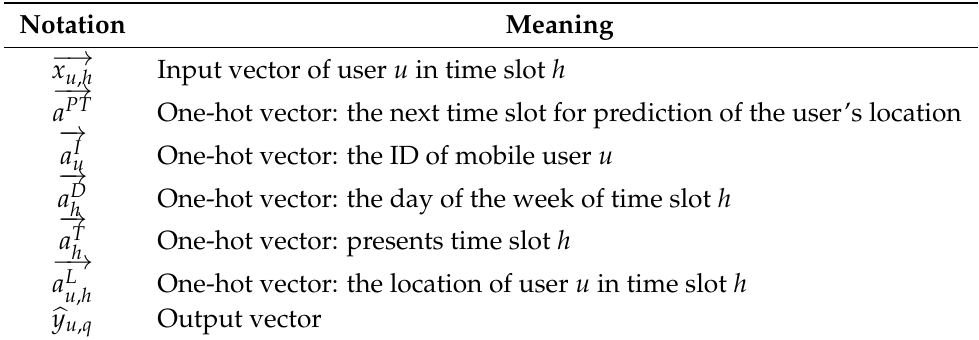
Table 1. Notations used in the human location prediction